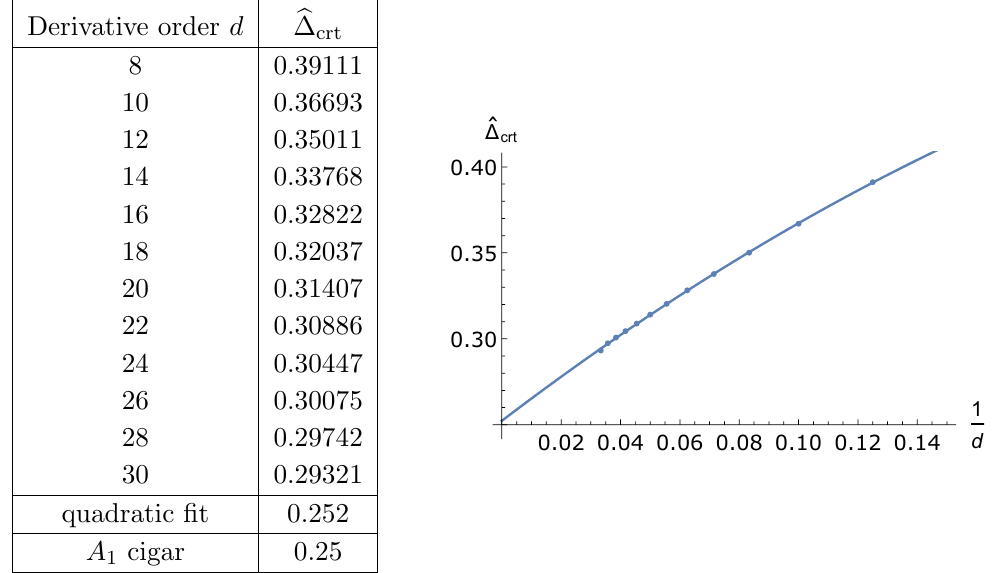
Table 3 . Upper bound b (cid:1) crt on the divergent operator of the lowest scaling dimension, as the derivative order is increased, as well as the extrapolation to in(cid:12)nite order using a quadratic (cid:12)t. Also shown is the value of (cid:1) crt for the A 1 cigar.